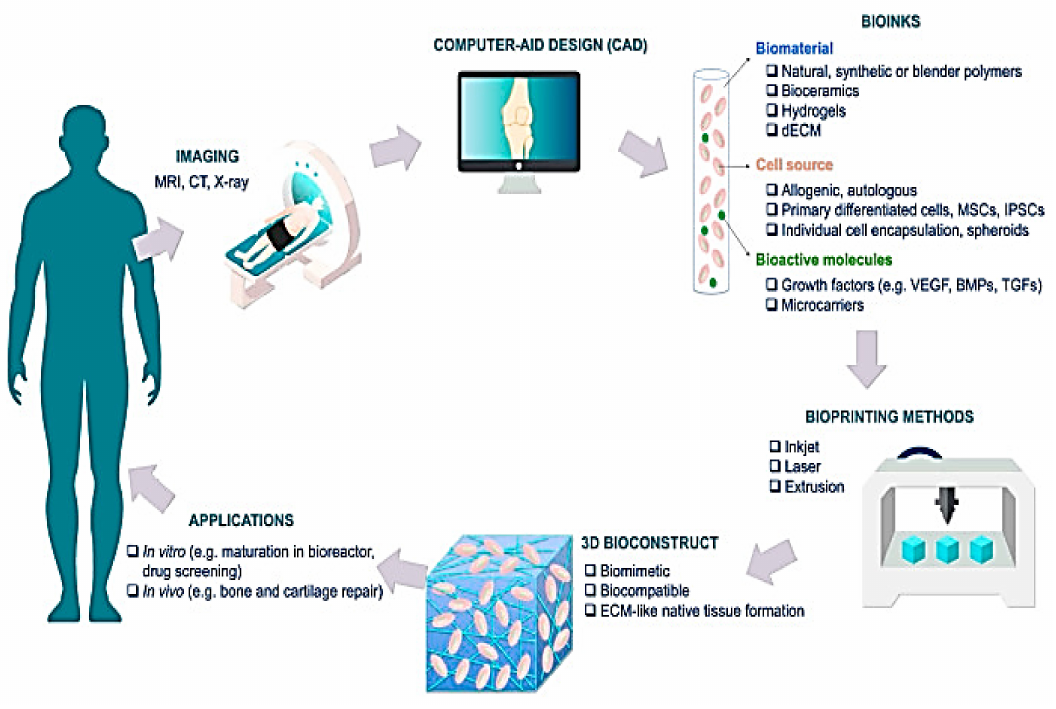
Figure 7. Diagrammatic representation of the bio-printing procedure for various tissue-engineering purposes. Reprinted with permission from [203]. Copyright 2020, MDPI. Distributed under Creative Commons Attribution—based license (CCBY